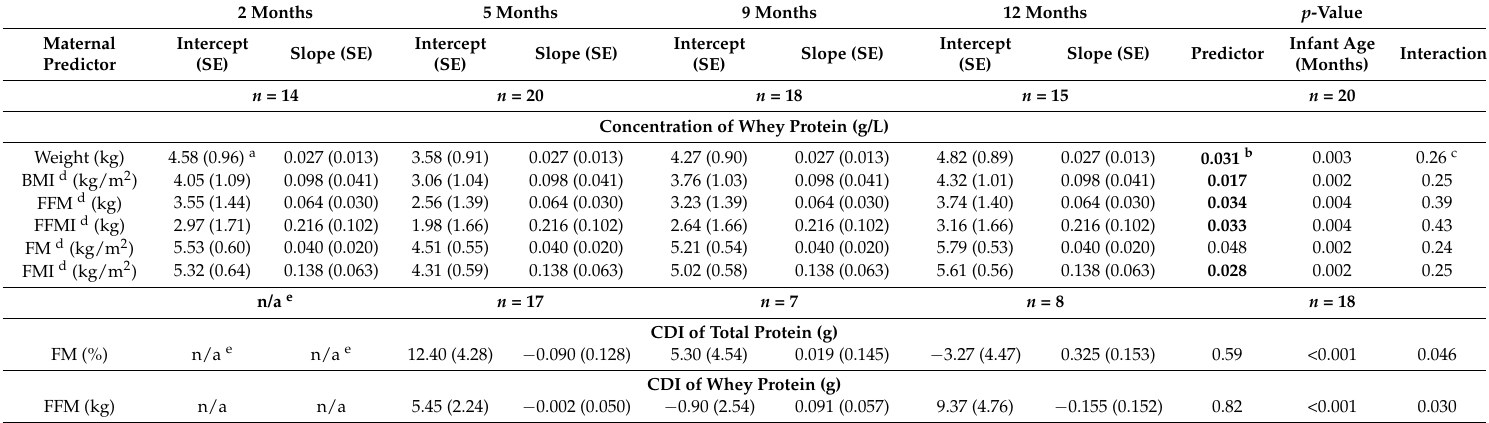
Table A1. Associations between maternal characteristics and human milk